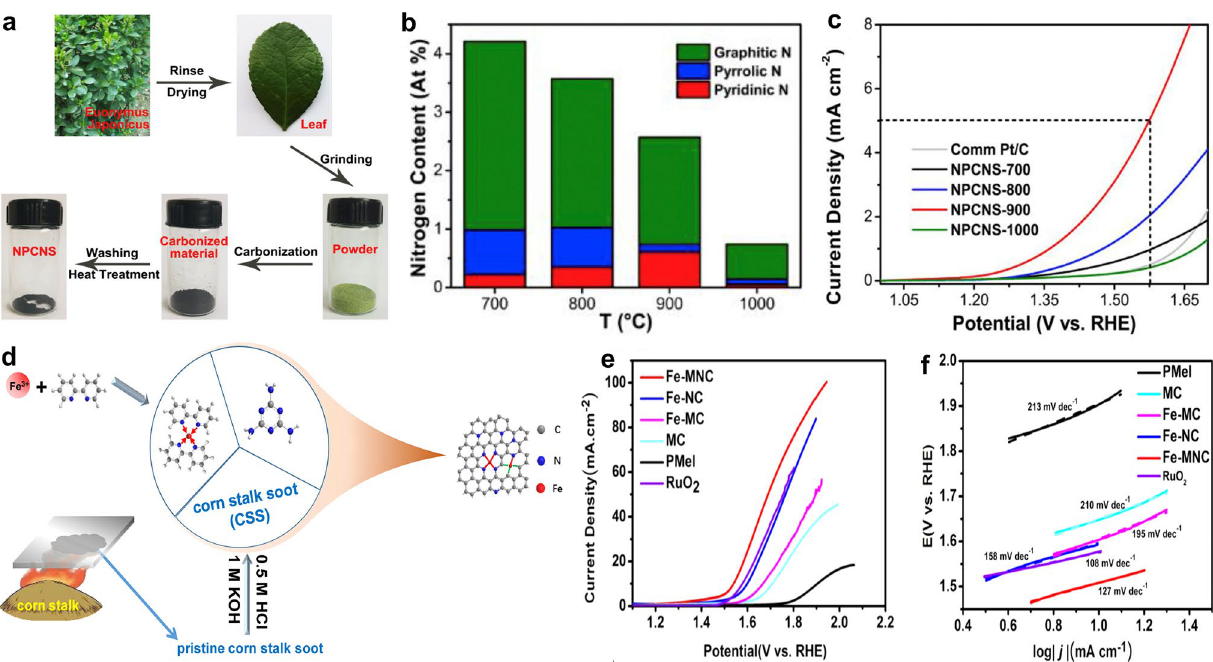
Fig. 8 a Scheme of synthesis of N‑doped porous carbon from plant leaves. b Nitrogen contents in carbon catalysts. c LSV curves of carbon catalysts and the Pt/C catalyst [138]. Copyright 2018, Elsevier. d Diagram of the fabrication of Fe, N co‑doped mesoporous and microporous carbon (Fe‑MNC). e LSV curves and f corresponding Tafel plots of catalysts in 0.1 M KOH [141]. Copyright 2022,